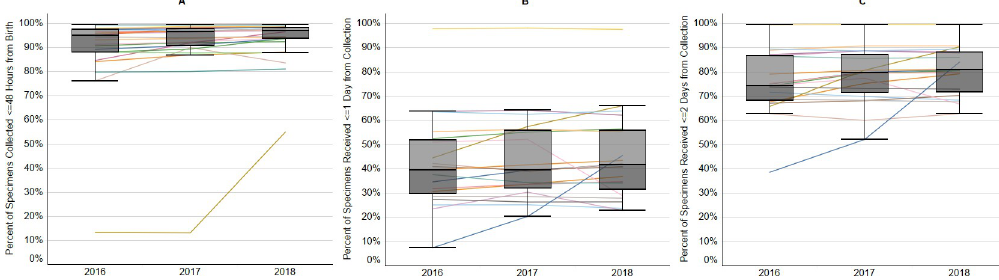
Fig 2. Percent of newborn screening dried blood spot specimens that achieved timeliness goals for collection and receipt at the testing laboratory. Data are presented for each state program individually, with box plots overlaid to demonstrate national trends. Box and whisker plots display the median of the percent of specimens that met the benchmark for each program, with upper and lower quartiles, and range. Panel A: Percent of specimens collected within 48 hours of birth, Panel B: Percent of specimens received at the laboratory within one day of collection (next calendar day), Panel C: Percent of specimens received at the laboratory within two calendar days of